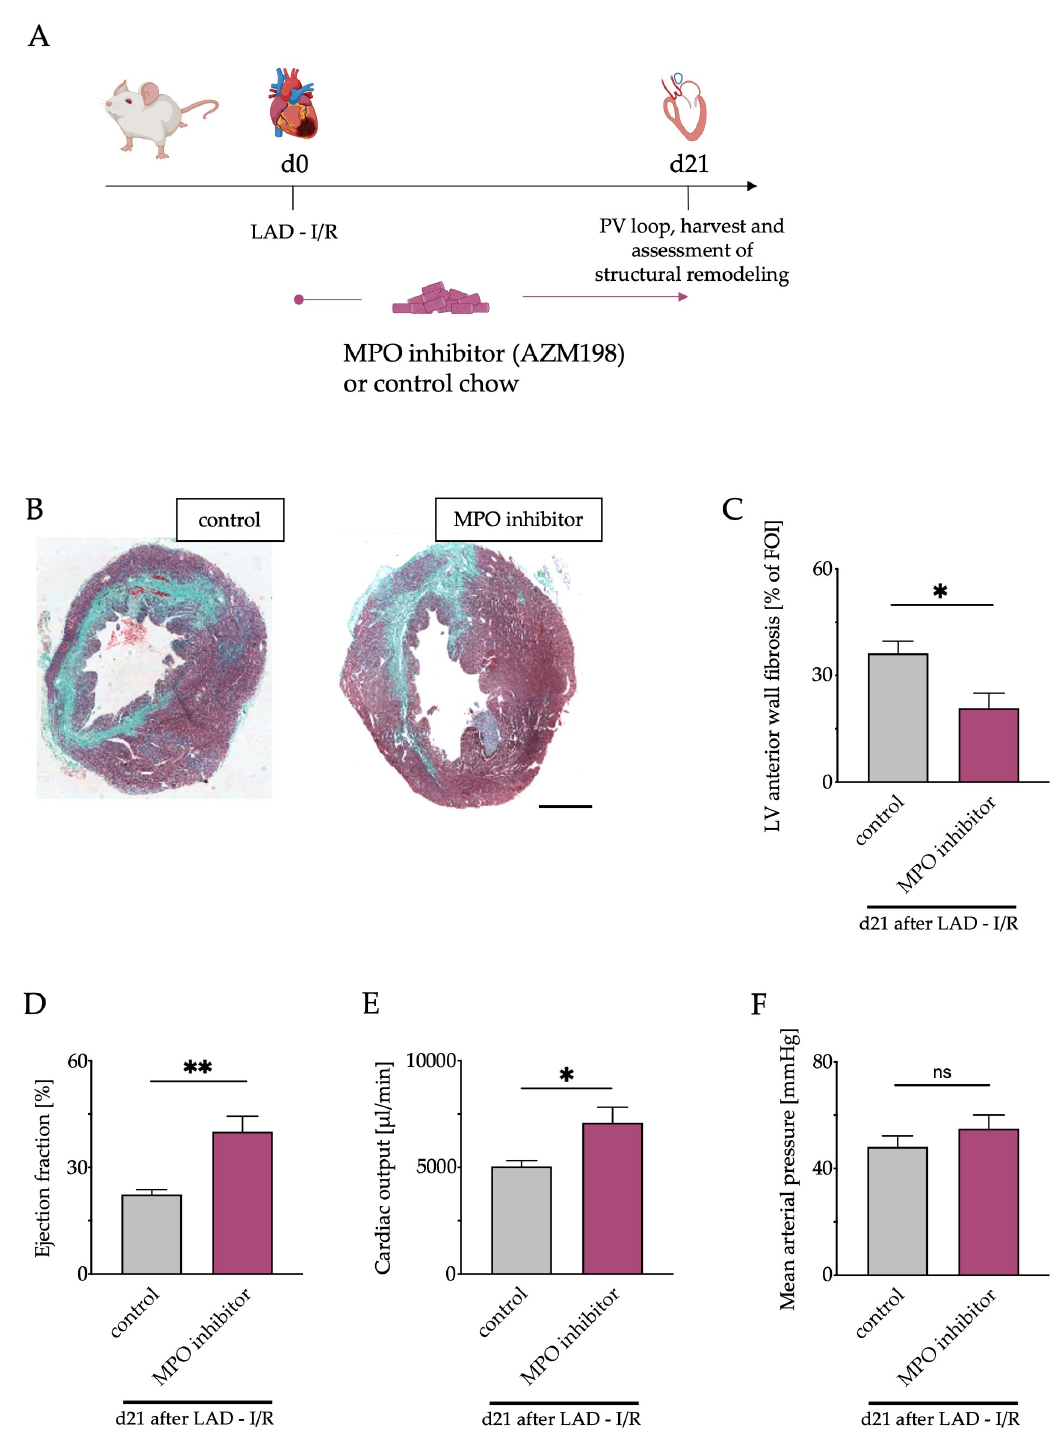
Figure 6. Pharmacological MPO inhibition mitigates cardiac remodeling and functional deterioration after MI. ( A ) Schematic timeline of MPO inhibitor treatment (AZM198) followed by LAD ligation and reperfusion (I/R) and final cardiac investigations. ( B ) Representative Masson’s trichrome stainings of murine hearts 21 days after I/R; scale bar = 1 mm. ( C ) Quantification of left ventricular fibrotic areas. ( D ) Quantitative analysis of LV ejection fraction, ( E ) cardiac output, ( F ) mean arterial pressure 21 days after I/R assessed by pressure–volume (PV) loop analysis. n = 5/7; * p < 0.05, ** p < 0.01, ns = not significant; one way ANOVA test followed by appropriate post hoc test, mean ± SEM is